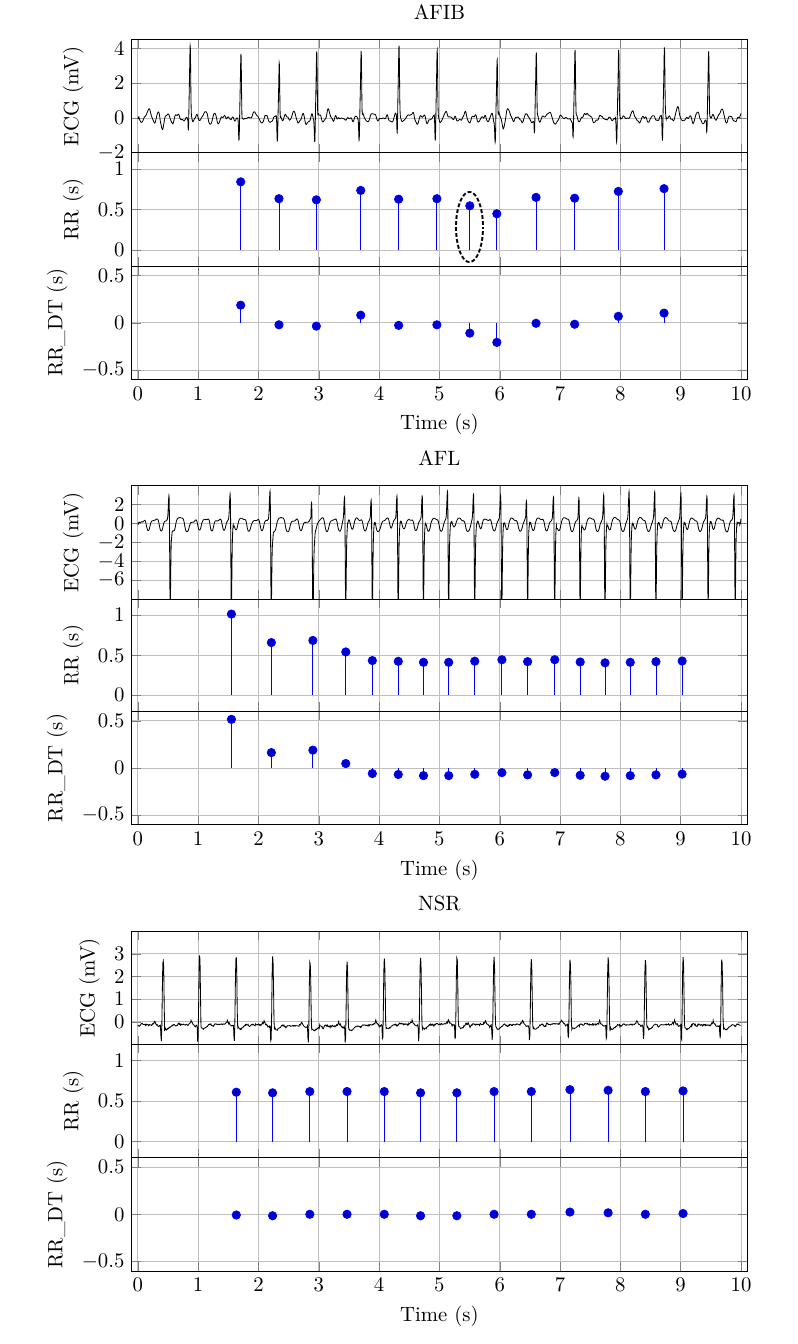
Figure 2. Example plots from AFIB, AFL, and NSR signal classes. The ECG signal was measured with the aVL lead. The RR intervals, plotted as RR intervals over time, were derived from the ECG via QRS detection. The detrended RR intervals were plotted as RR_DT over time. Visual inspection indicates that the AFIB RR (s) signal shows an additional beat, which has been encircled with a dashed